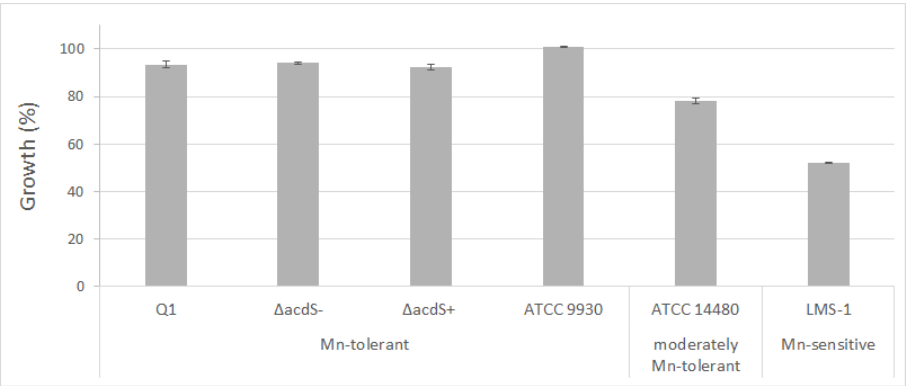
Figure 2. Growth of Pseudomonas sp. Q1 and its derivatives strains (∆ acdS mutant and ∆ acdS + ) and rhizobial strains ( M. ciceri LMS-1, R. leguminosarum ATCC 14480 T , E. meliloti ATCC 9930 T ) under